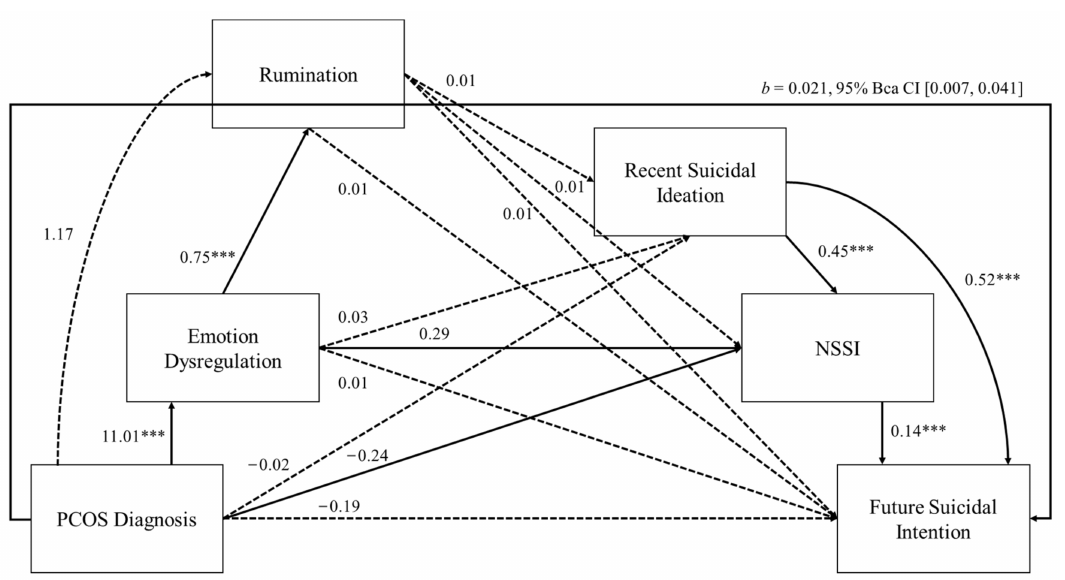
Figure 1. Full series mediation model. Notes. *** p < 0.001; regression coefficients are unstandardized; solid lines = significant paths; dotted lines = non-significant paths. Model controls for variation in age, education and